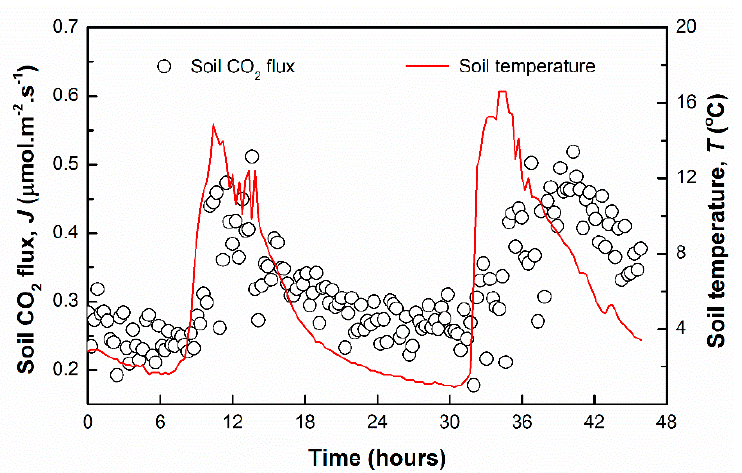
Figure 9. Variation trend of soil flux and soil temperature at a depth of 7 cm, as recorded at Location A (Dec 30, 2016 to Dec 31, 2016).